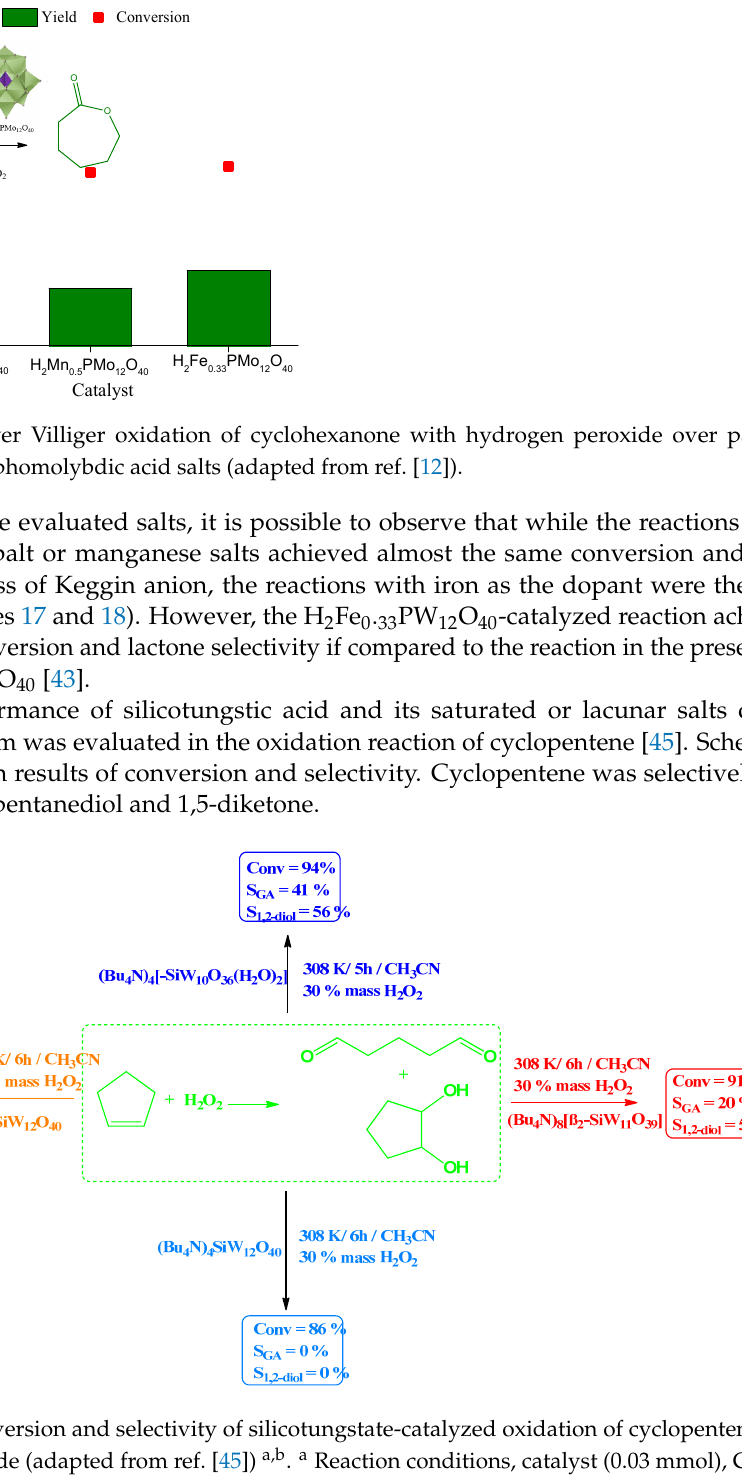
Figure 17. Baeyer Villiger oxidation of cyclohexanone with hydrogen peroxide over partially ex- changed-phosphotungstic acid salts (adapted from ref. [12]).